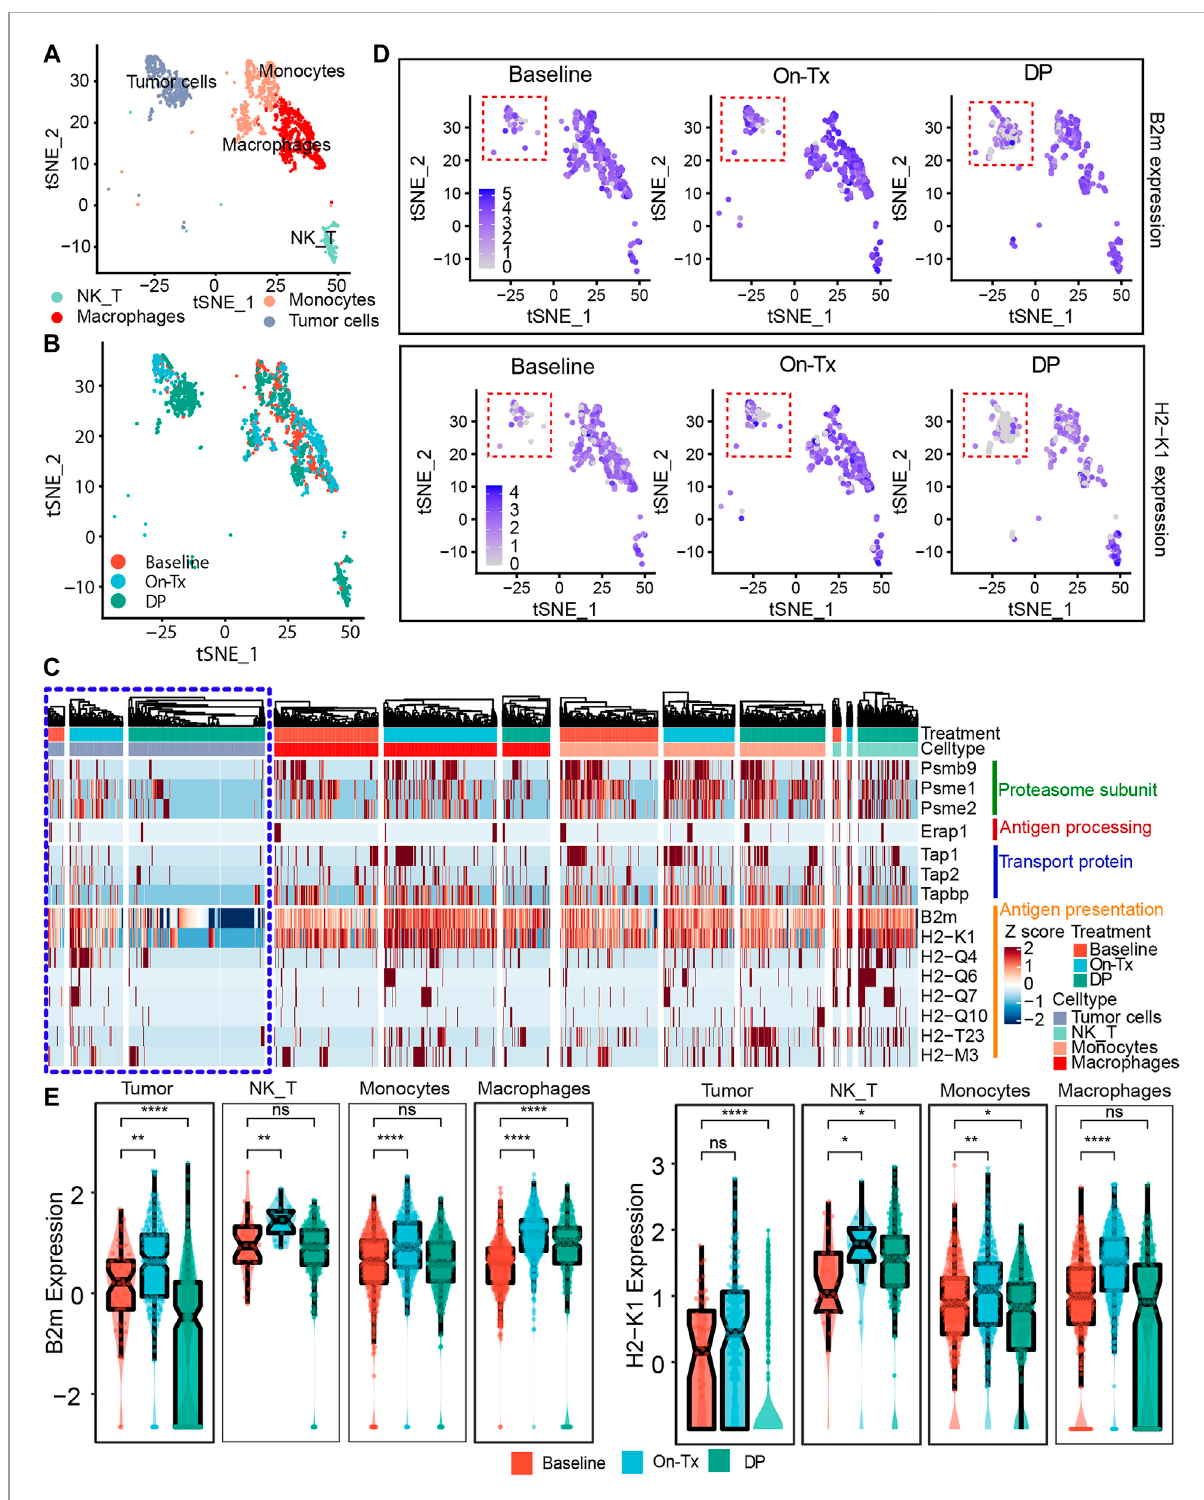
FIGURE 6 Expression of MHC-I molecules in different cell types. (A) t-SNE plot showing mouse single cells at different stages of the BRAFi response. Different colors indicate different cell types (GSE126714). (B) t-SNE plot showing mouse single cells at different stages of the BRAFi response. Different colors indicate different stages of BRAFi processing. (C) Heatmap showing the expression changes of MHC-I molecules in tumor cells (purple box marker), T/NK cells, macrophages, and monocytes at different stages of the BRAFi response. (D) Single-cell RNA-seq featurplot